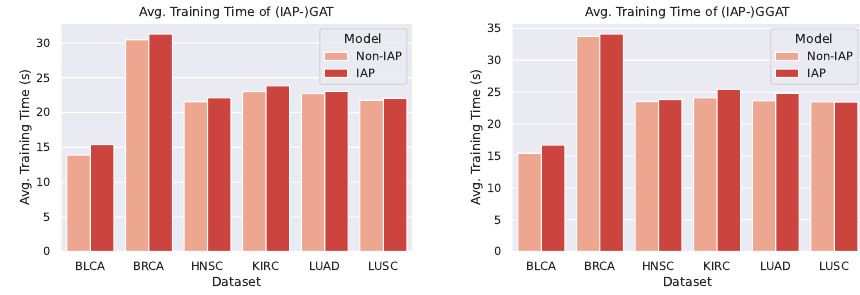
Figure 14. Comparison of (IAP-)GAT’s and (IAP-)GGAT’s average training